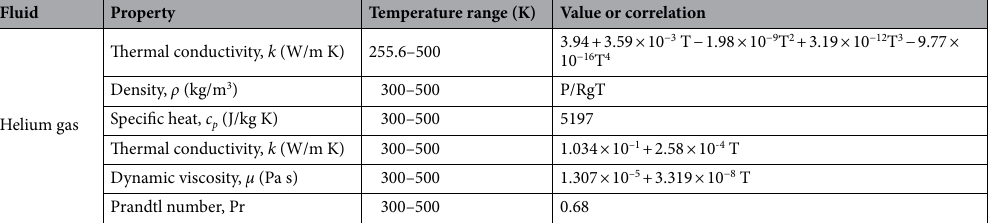
Table 1. Thermo-physical properties of helium gas 22